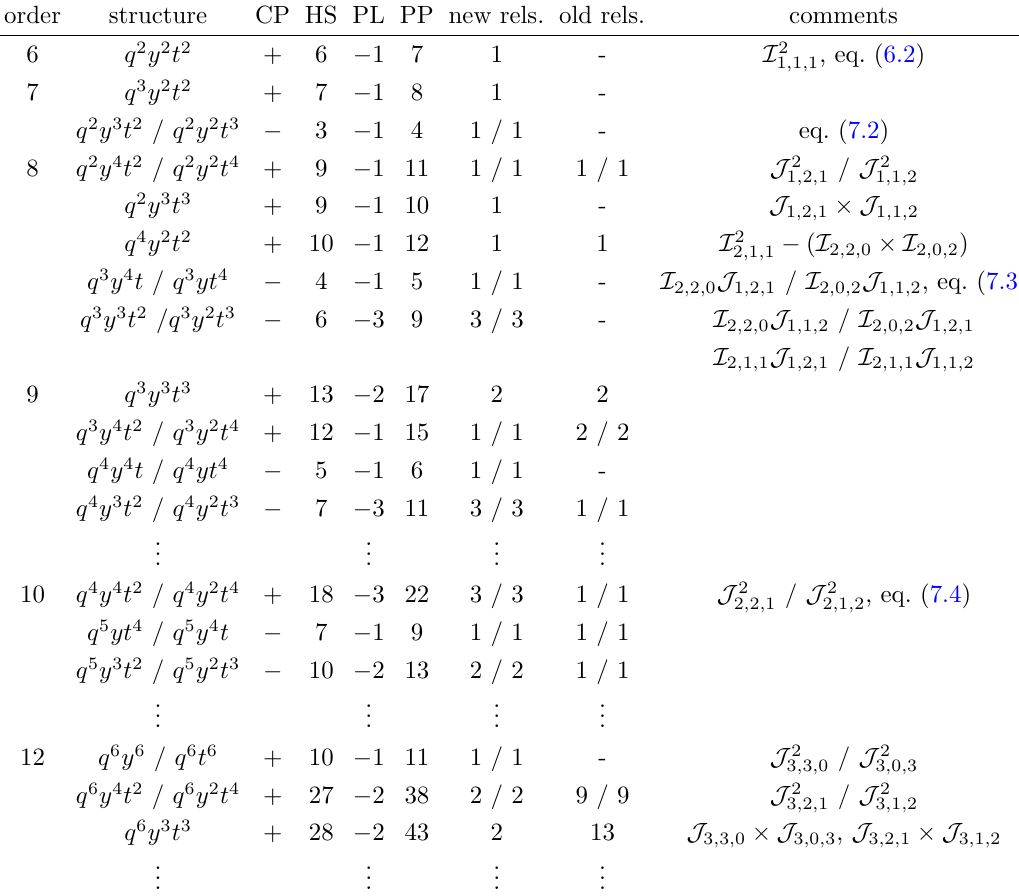
Table 1 . List of the syzygies of the 2HDM scalar sector. The (cid:12)rst columns give the order, structure and CP transformation behavior of the relation. The following columns summarize the corresponding coe(cid:14)cients of the multi-graded Hilbert series (HS), Plethystic logarithm (PL) as well as the number of new relations that are arising (as evidence that the PL coe(cid:14)cient indeed gives this number correctly). Furthermore, we list the total number of power products of generating invariants which give rise to the same structure (this is an indicator of how many previously found \old" relations appear in addition to possible new relations). The last column gives important structures of invariants that appear in the given